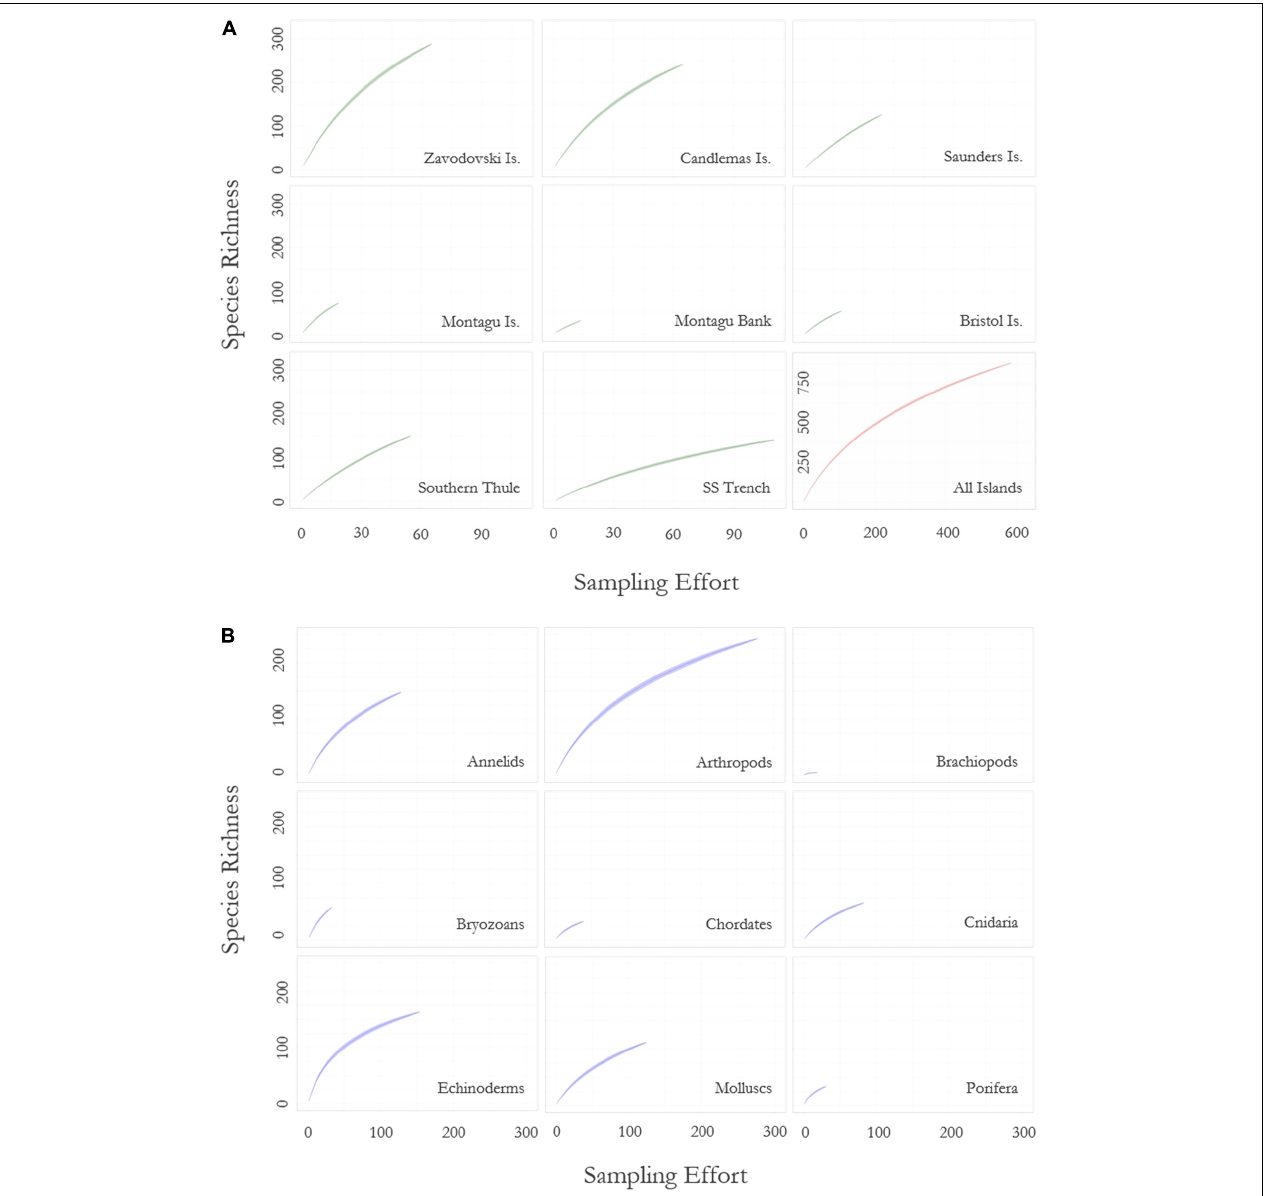
FIGURE 3 | Rarefaction curve showing (A) the rate of species accumulation with increasing sampling effort for each of the South Sandwich Islands, and (B) the rate of species accumulation with increasing sampling effort across nine major phyla (chordates excludes fish). Islands are delineated by 1,500 m depth contours. Zavodovski Island includes Protector shoal; Candlemas includes Visokoi Island and Southern Thule includes the Adventure and Kemp Caldera. Sample effort is defined by number of sampling sites. Green ribbons (for islands) and blue ribbons (for phyla) denote standard deviation over 1,000 permutations. The “All Islands” plot (red ribbon) shows species accumulation across the entire study